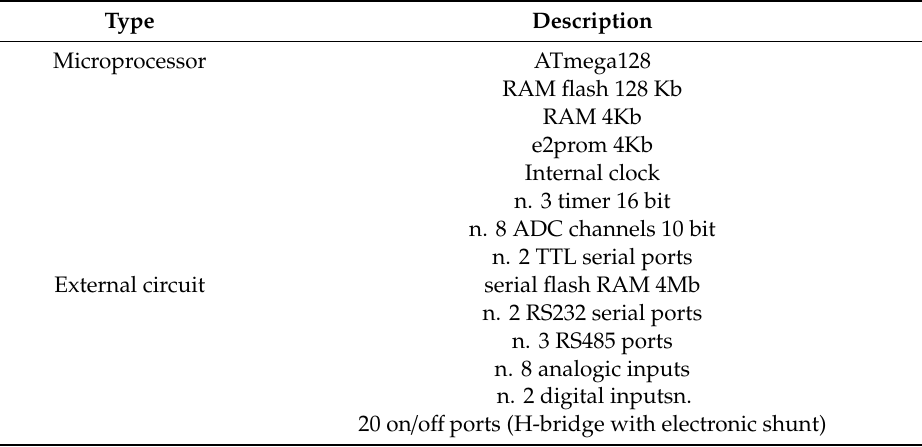
Figure A4. Filtering, subdivision into aliquots, and treatment of the water samples collected by the syringes of the Amerigo Lander is conducted in a Nitrogen glove-box. Table A1. Main configuration of the Amerigo Lander